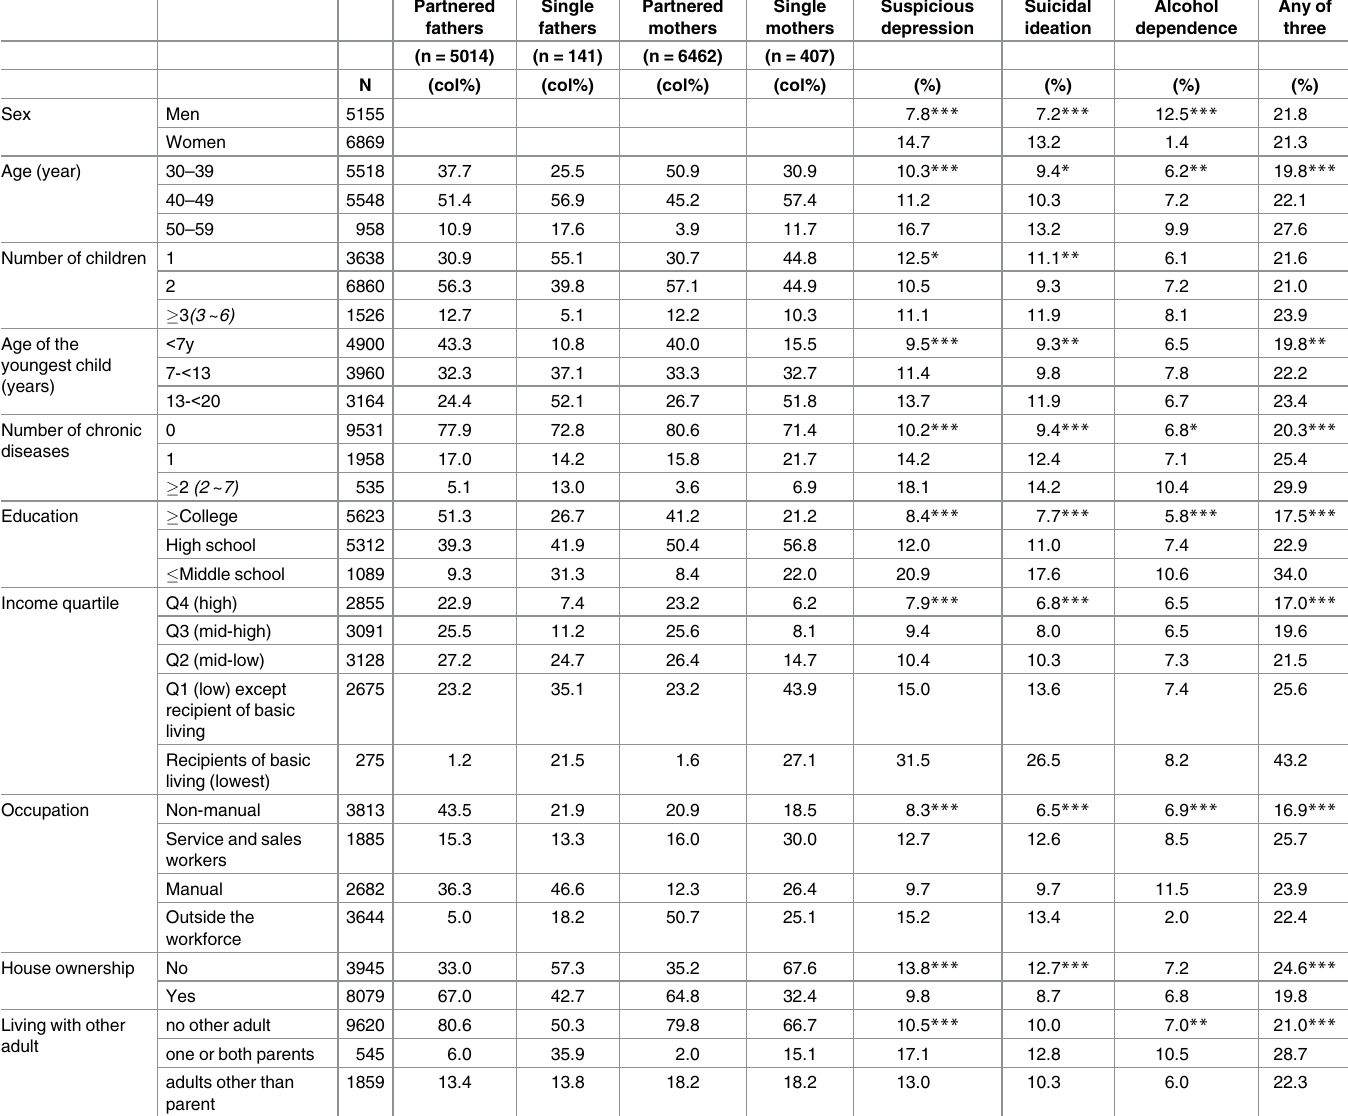
Table 1. Characteristics of partnered and single